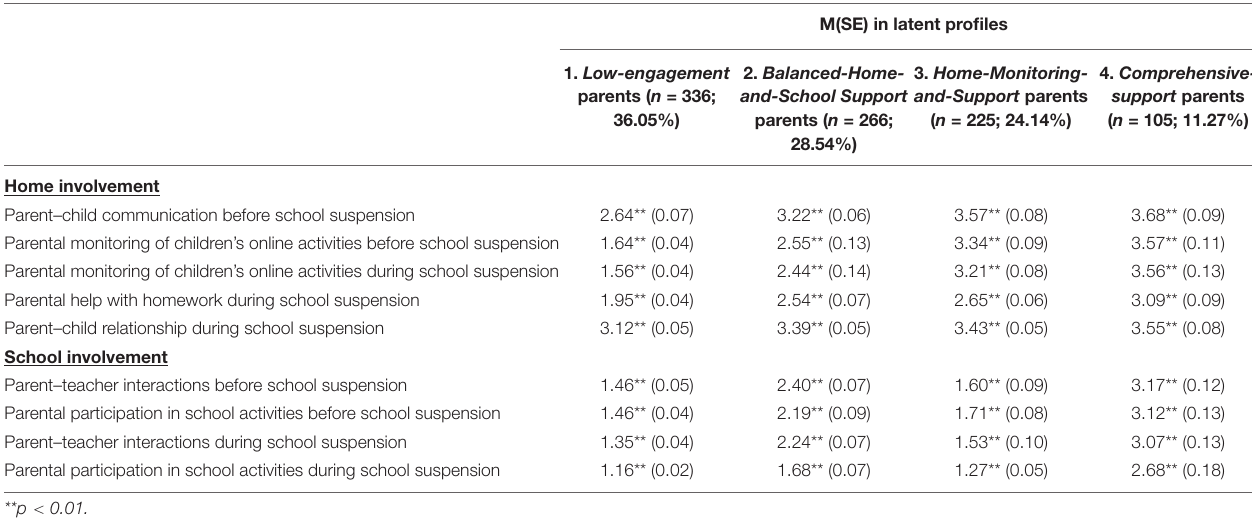
TABLE 11 | Descriptives for parenting variables (secondary schools).